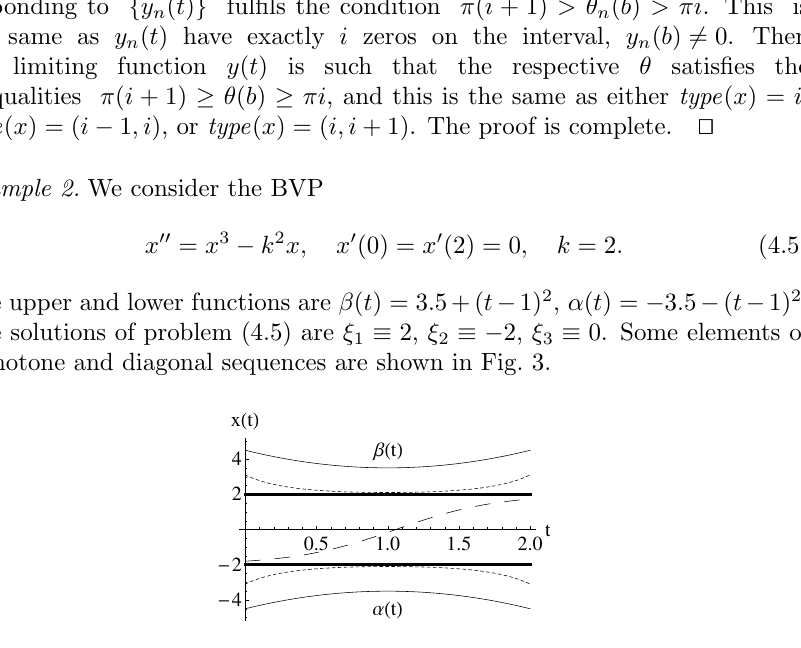
Figure 3. Sequences converging to the solutions of Neumann problem